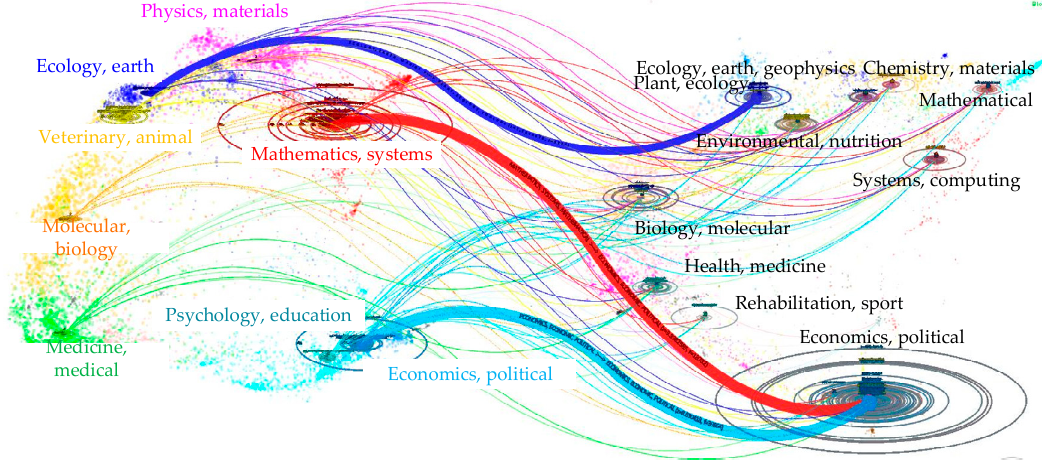
Figure 7. A dual-map overlay of the literature’s journals.